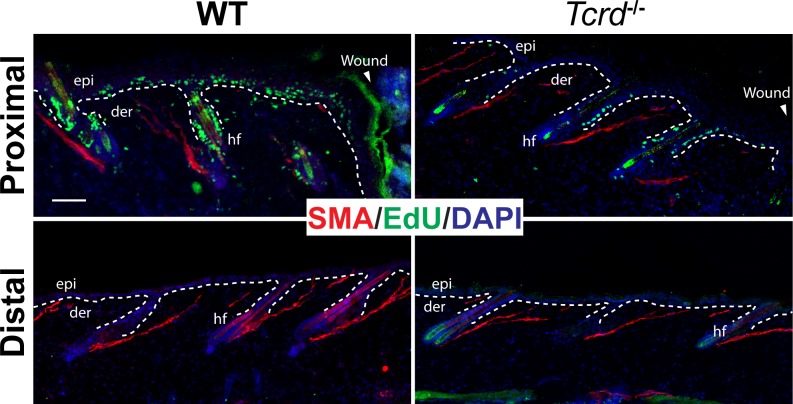
Loss of γδT-cells phenocopies the proliferation deficiency of IL-1 signaling in excisional cutaneous wounds.Immunofluorescence images of day 3 wound proximal and distal skin sections from 8-week-old WT or γδT-deficient mice. Sections were labelled with anti-SMA antibody to mark the hair-bulge region (red) and with EdU to detect actively proliferating cells. Nuclei were stained with DAPI (blue). Scale bar = 50 µm. The dotted line represents the epidermal–dermal interface.